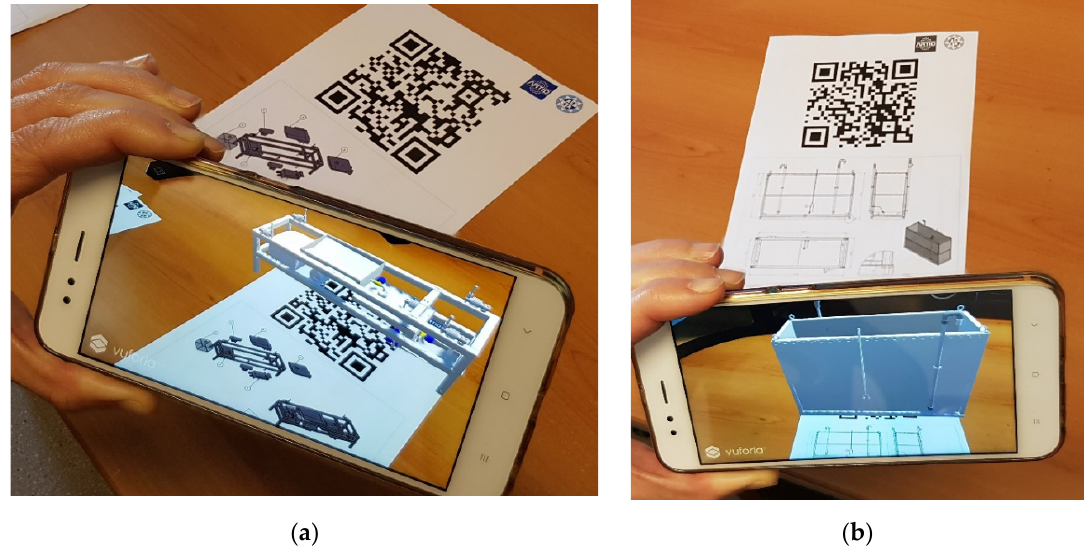
Figure 12. Viewing two ferticontrol equipment structures with the Augmented Reality for Teaching, Innovation and Design (ARTID) application: ( a ) inner structure; ( b ) main structure.